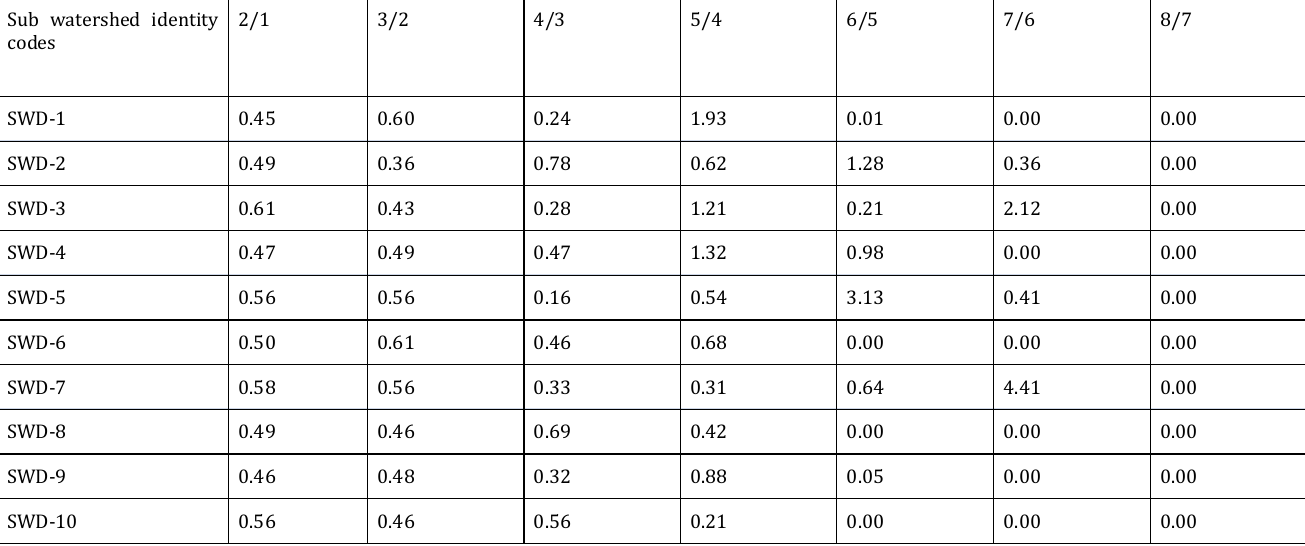
Table 8: Stream length ratio of upper watershed of river Subarnarekha